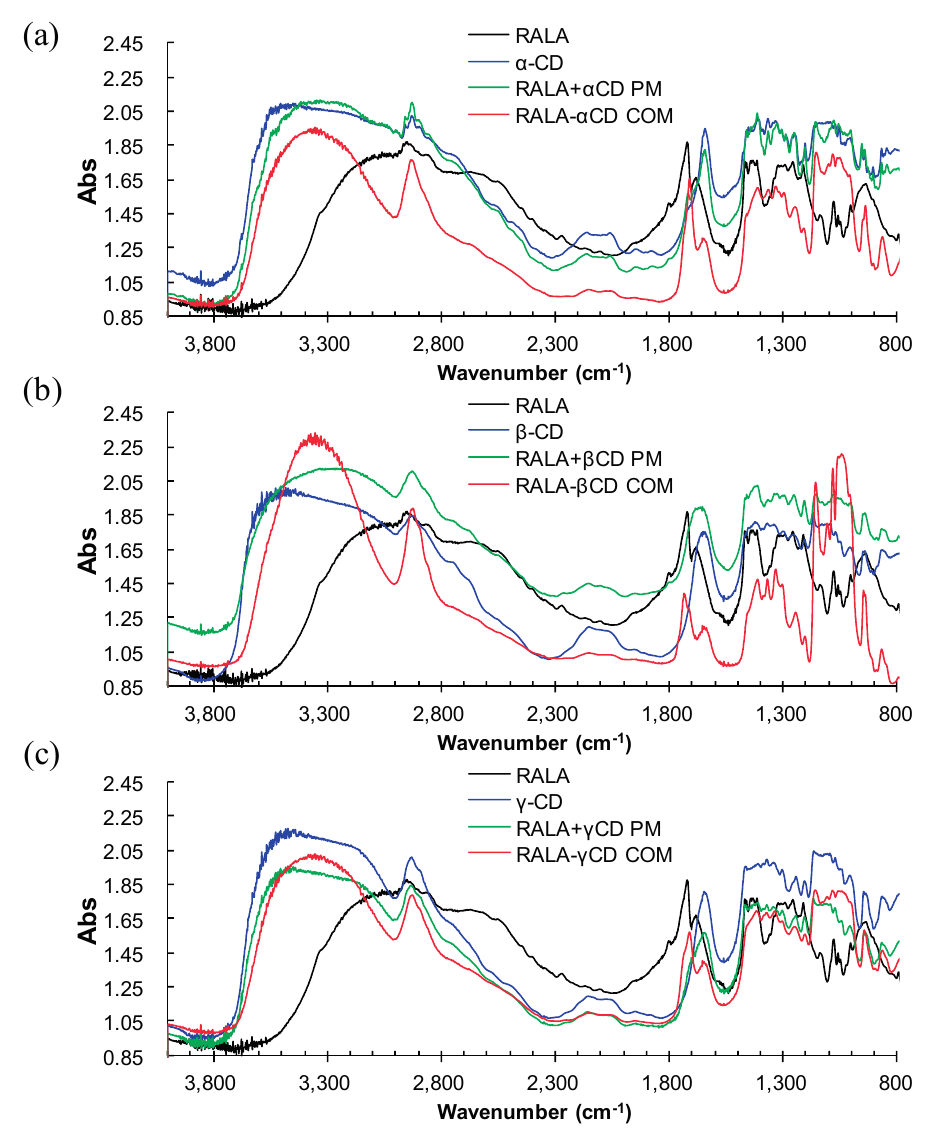
Figure 4. Micro-FT-IR spectra of RALA, RALA + CD physical mixture (PM) and RALA-CD complex (COM). (( a ) α -CD; ( b ) β -CD and ( c ) γ -CD).